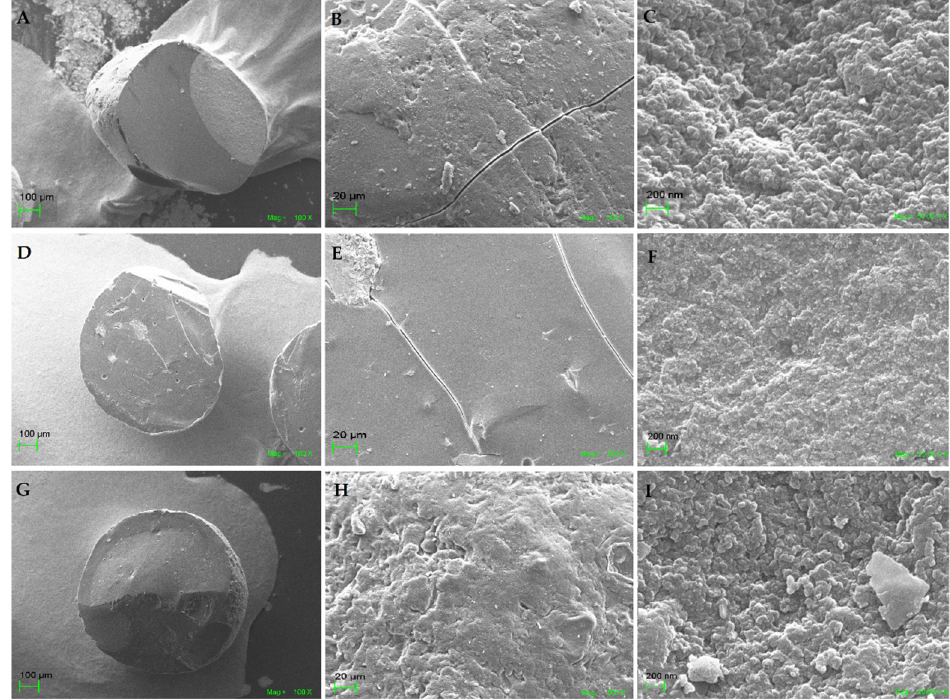
Figure 1. SEM morphology images for the nanocomposite beads CS-GLA: ( A ) 100 × , ( B ) 500 × , ( C ) 50,000 × ; CS-TiO 2 -GLA: ( D ) a 100 × , ( E ) 500 × , ( F ) 50,000 × and CS-GO-TiO 2 -GLA: ( G ) a 100 × , ( H ) 500 × , ( I ) 50,000 ×